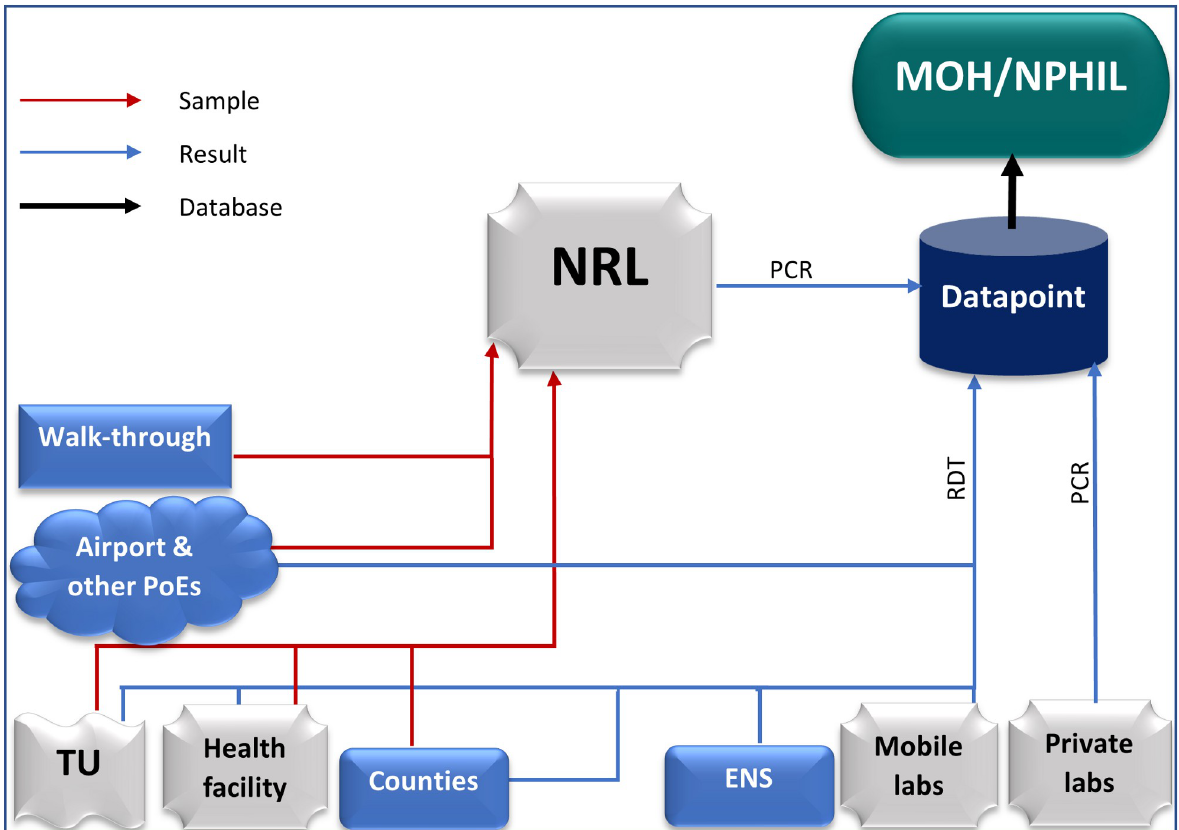
Fig 1. COVID-19 Epi-data flowchart in Liberia, July 2021. Note: Ministry of Health (MOH), National Public Health Institute of Liberia (NPHIL), National Reference Lab (NRL), Treatment Unit (TU), PoE (Points of Entry), and Enhanced Active Surveillance (ENS).